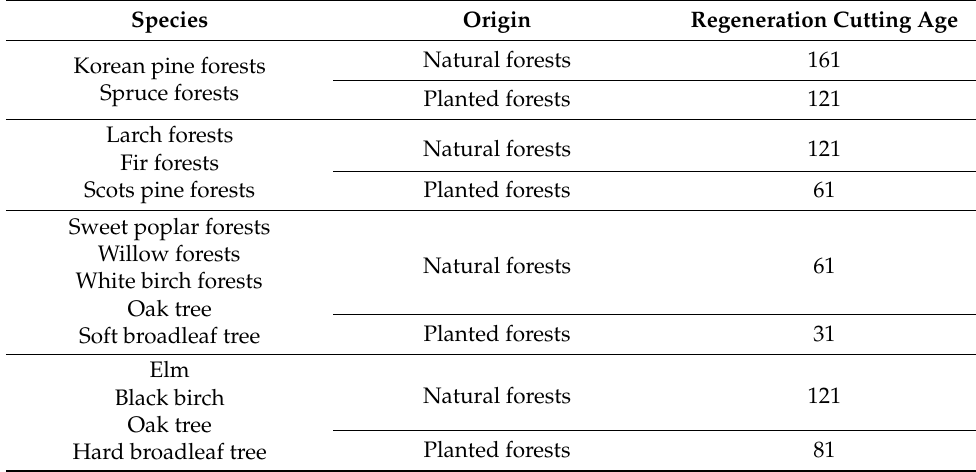
Table A3. Regeneration cutting age set by the Inner Mongolia government in 2016